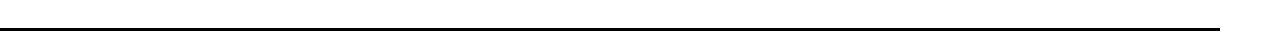
Fig. 3 BRE overexpression affects IR-induced CDC25A degradation. a DNA synthesis in ES cells after different doses of IR. b Western blot analysis of CDC25A and Tyr15 phosphorylation of CDK1 (p-CDK1) at different times after exposing the cells to 6 Gy IR in Brca2 CKO/KO ;MSCV-BRE cells compared to Brca2 CKO/KO cells. GAPDH was used as a loading control. Numbers below indicate the lane numbers. The quanti fi cation of CDC25A (middle panel) and p- CDK1 (lower panel) band intensity for each cell line is shown as histogram. Relative band intensities were calculated by dividing GAPDH-normalized CDC25A/p-CDK1 intensity at particular time point with GAPDH-normalized CDC25A/p-CDK1 intensity of corresponding untreated cells. c MCF7 cells with inducible HA-BRE expression cassette were transfected with CRE plasmid and subjected to 6 Gy IR after 48 h of transfection. Western blots of endogenous CDC25A in presence (lanes 4 – 6) and absence (lanes 1 – 3) of HA-BRE expression at different times after irradiation is shown in the upper panel. Lower panel shows the quanti fi cation of CDC25A band intensity normalized against GAPDH. d Immunoblot showing CDC25A degradation after IR treatment in MCF7 cells transfected either with non-speci fi c (NS) siRNA or two different siRNAs against BRE (#1 and #2). Histone H3 was used as a loading control. Relative CDC25A band intensities were calculated by dividing GAPDH-normalized CDC25A intensity at a particular time point with GAPDH-normalized CDC25A intensity of untreated (0 h IR) cells of corresponding siRNA treatment. e Western blot showing IR-induced CDC25A degradation in MCF7 cells with stably integrated CRE inducible HA-BRE expression cassette after transfection either with non-speci fi c (NS) siRNA or two different siRNAs against MERIT40 (#1 and #2) along with CRE -expressing plasmid. Non-speci fi c (NS) siRNA transfection was used as control. Relative abundance of CDC25A at a particular time point was measured by comparing GAPDH-normalized band intensities at that point divided by GAPDH- normalized CDC25A intensity of untreated (0 h IR) cells of corresponding treatment. All histograms show the average of three independent experiments and error bars represent s.d. P values were calculated using paired two-tailed t -test and tabulated in Supplementary Table